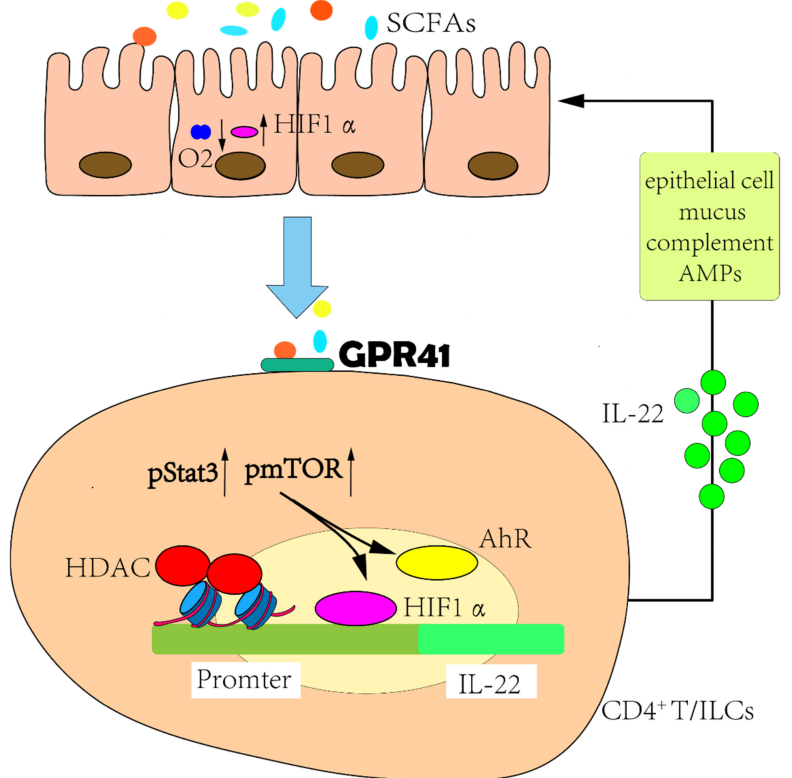
Figure 3. SCFAs promote the production of IL-22. Short-chain fatty acids (SCFAs) promote the expression of hypoxia-inducible factor 1 α (HIF1 α ) and binding to the interleukin-22 (IL-22) by binding to G-protein receptor 41 (GPR41) on the surface of innate lymphoid cells (ILCs) and CD4 + T cells and inhibiting histone deacetylase. Finally, the elevated secretion of IL-22 further improves intestinal function. ↑ denotes increase; ↓ denotes decrease; SCFAs, short-chain fatty acids; GPR41, G- protein receptor 41; IL-22, interleukin-22; AhR, aryl hydrocarbon receptor; HIF1 α , hypoxia-inducible factor 1 α ; HDAC, histone deacetylase; ILCs, innate lymphoid cells; AMPs, antimicrobial